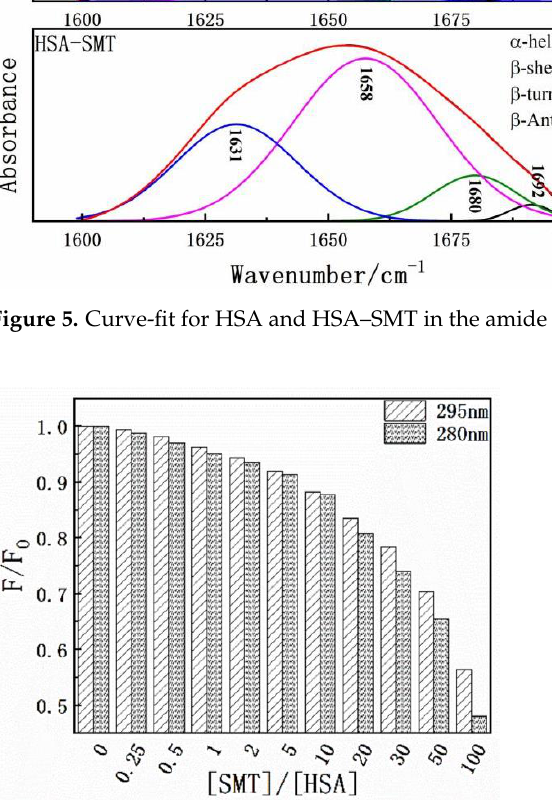
Figure 6. Effect of SMT on HSA fluorescence intensity at λ ex = 280 nm and λ ex = 295 nm.